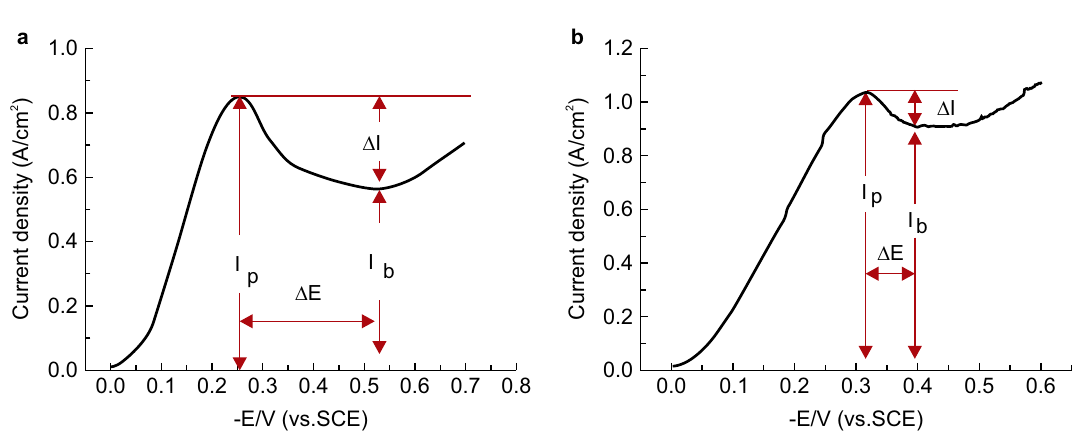
Figure 3. LSV measured in the plating bath. ( a ) Plating solution with SH110 and ( b ) plating solution with